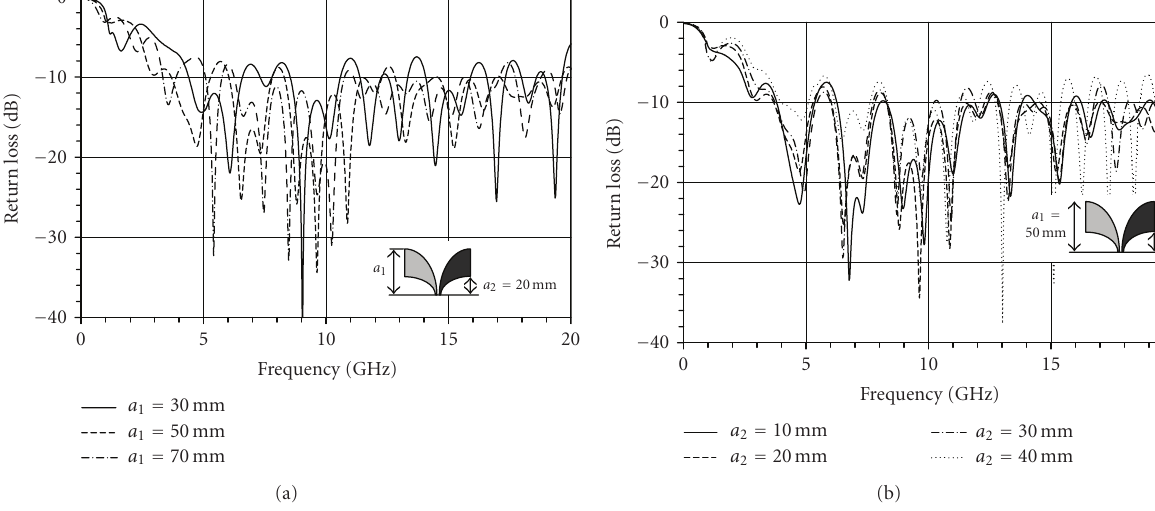
Figure 4: Return loss for varying the side intercepts, a 1 − a 2 , of the slotline